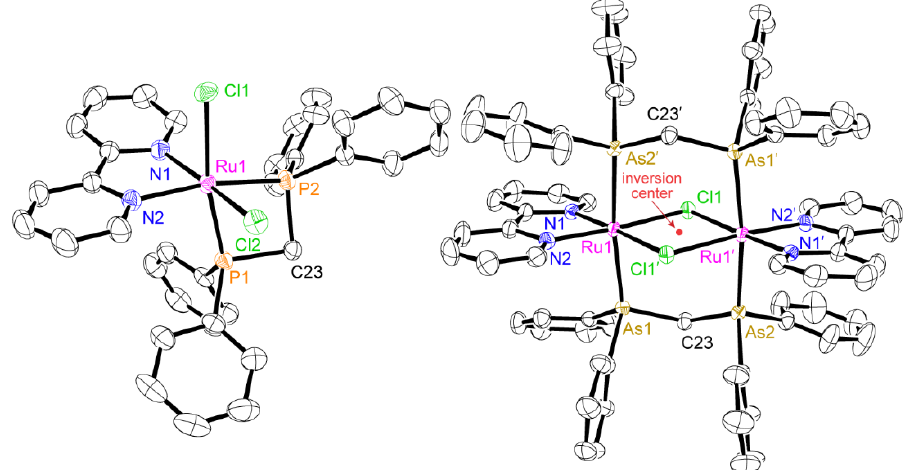
Figure 1. Perspective views of 1 (left) and [ 3 ] 2+ (right) as represented by 50% probability ellipsoids (hydrogen atoms are omitted for clarity). Selected bond lengths (Å ) and angles (°): 1 : Ru1−Cl1 2.5059(6) , Ru1−Cl 2 2.4387(7) , Ru1−N1 2.063(2) , Ru1−N2 2.115(2) , Ru1−P1 2.2654(7) , Ru1−P2 2.2966(7),